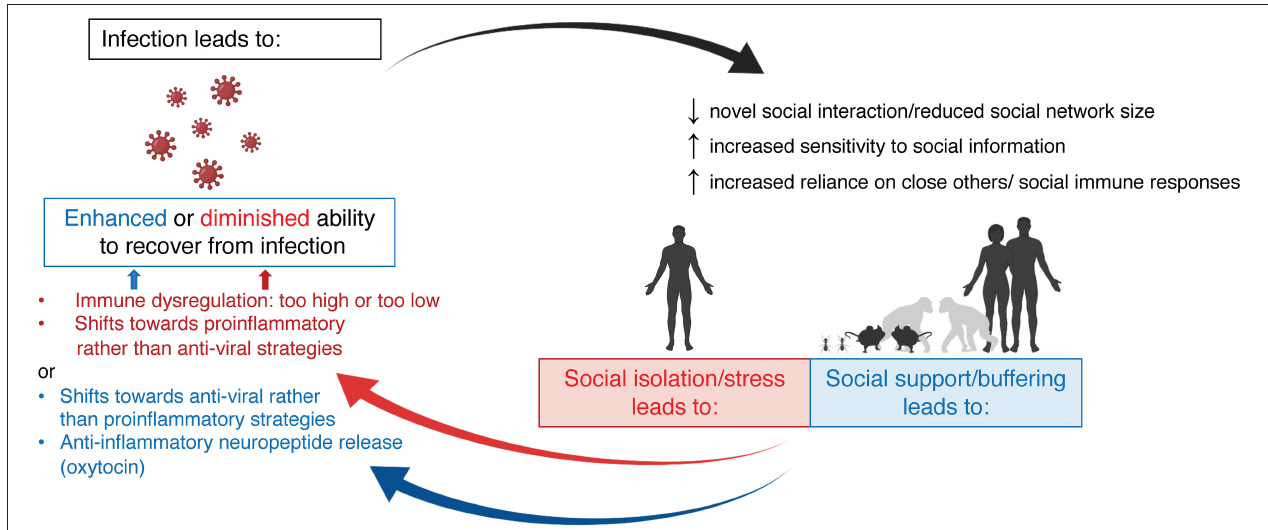
FIGURE 1 | The bi-directional relationship between infection and social behavior. Infection (either viral or bacterial) induces social withdrawal and decreases social network size, across species. Infection also increases sensitivity to social information and increases social interactions with familiar peers and family members. Together, these changes in social behavior aim to reduce disease transmission while promoting individual recovery. Social context can also impact immune function. Social isolation, social stress, or low position within a social hierarchy all lead to immune dysfunction—often shifting immune responses toward pro-inflammatory rather than anti-viral strategies. Conversely, strong social bonds and high social status are associated with a shift in immune responses toward anti-viral strategies and higher oxytocin release, which may act as an anti-inflammatory mediator. Created with